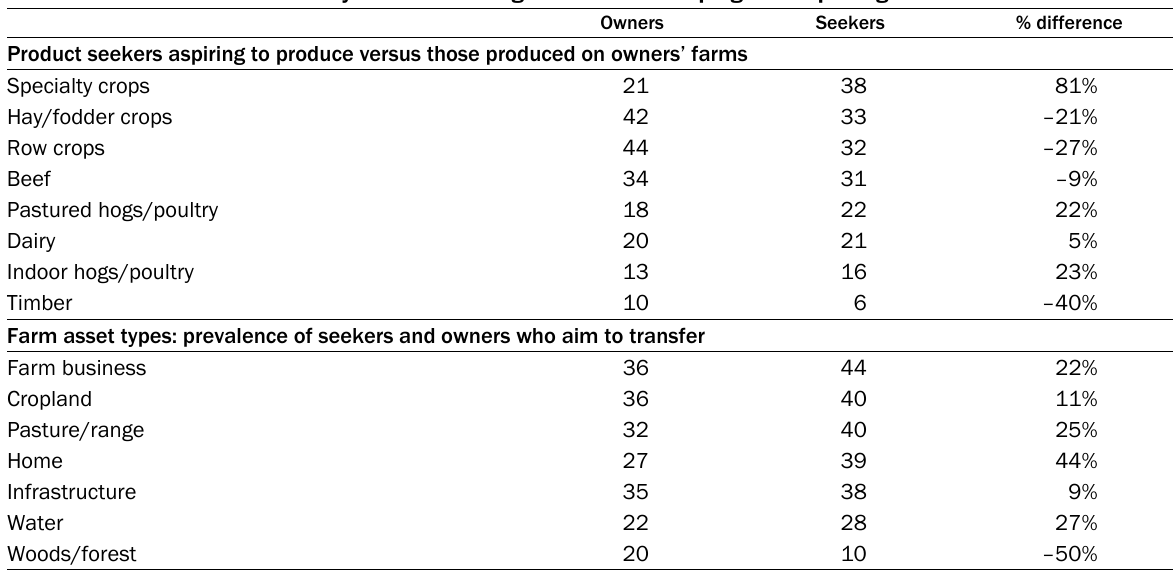
Table 1. Phase 1 Comparison of Seeker Needs and Owner Offers, Weighted by the Prevalence of Interest Farm Link Service Providers Observe among Their Participants (in Order of Descending Seeker Interest) Analysis 1 — According to the number of programs